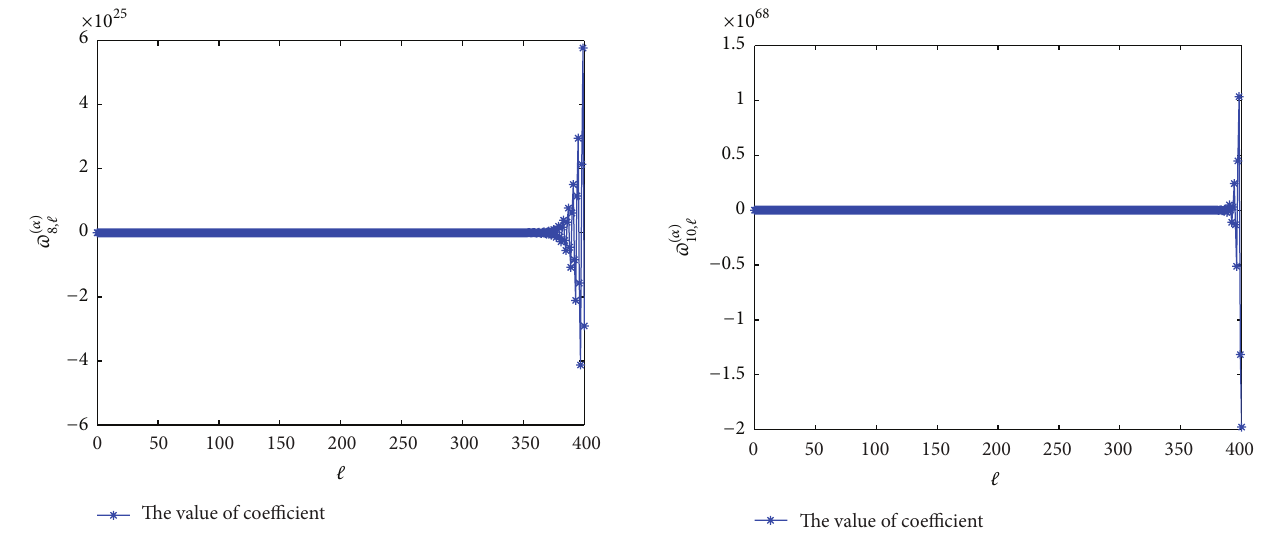
Figure 6: The values of the coefficients 𝜛 (𝛼) 8,ℓ (ℓ = 0, 1, . . .) for 𝛼 = 0.3 .